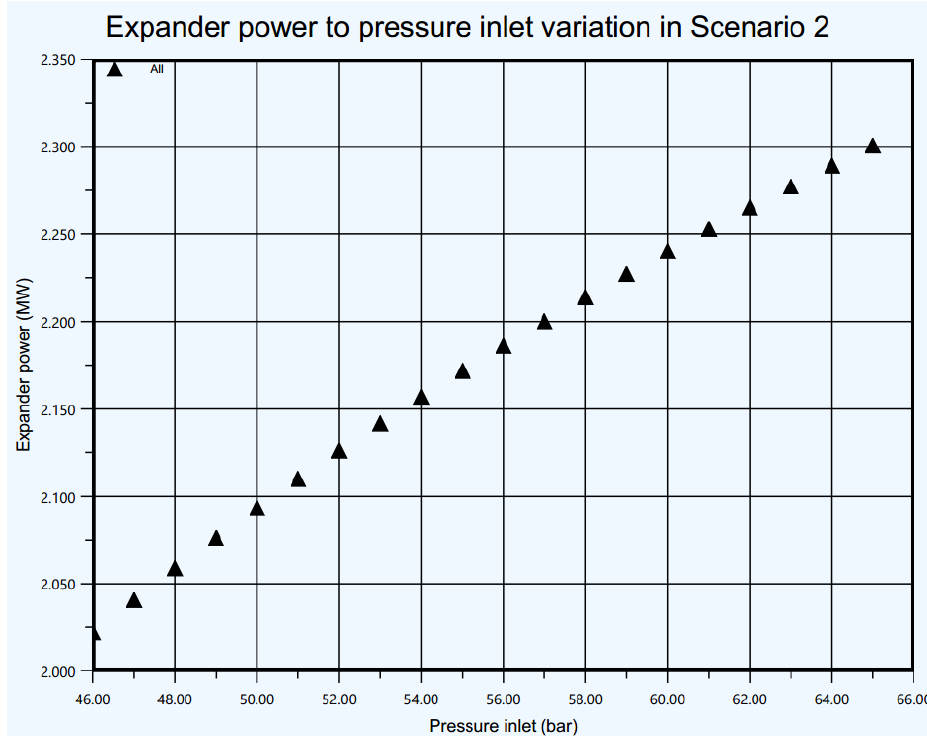
Figure 10. Expander power to gas feed pressure curve for scenario 2.